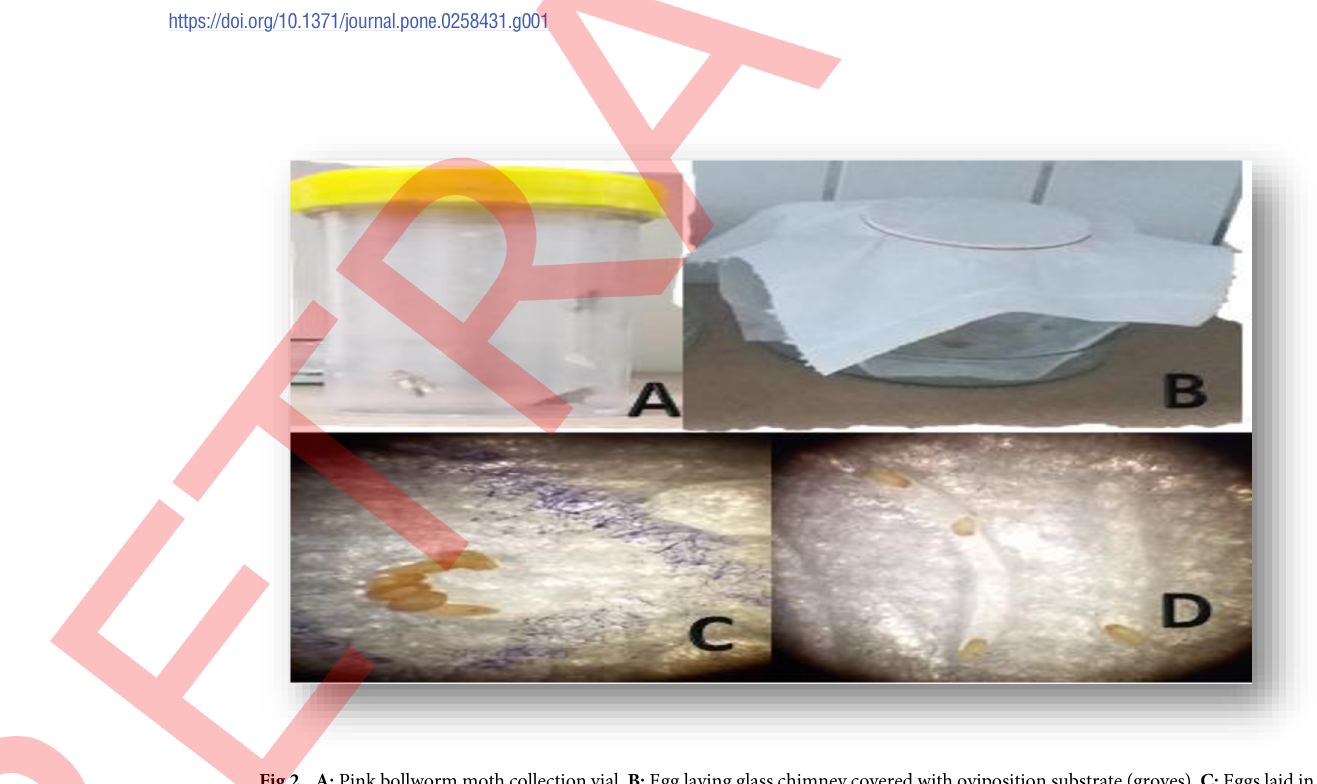
Fig 2. A: Pink bollworm moth collection vial. B: Egg laying glass chimney covered with oviposition substrate (groves). C: Eggs laid in batches. D : Singly egg laid pattern in groves in towel tissue.